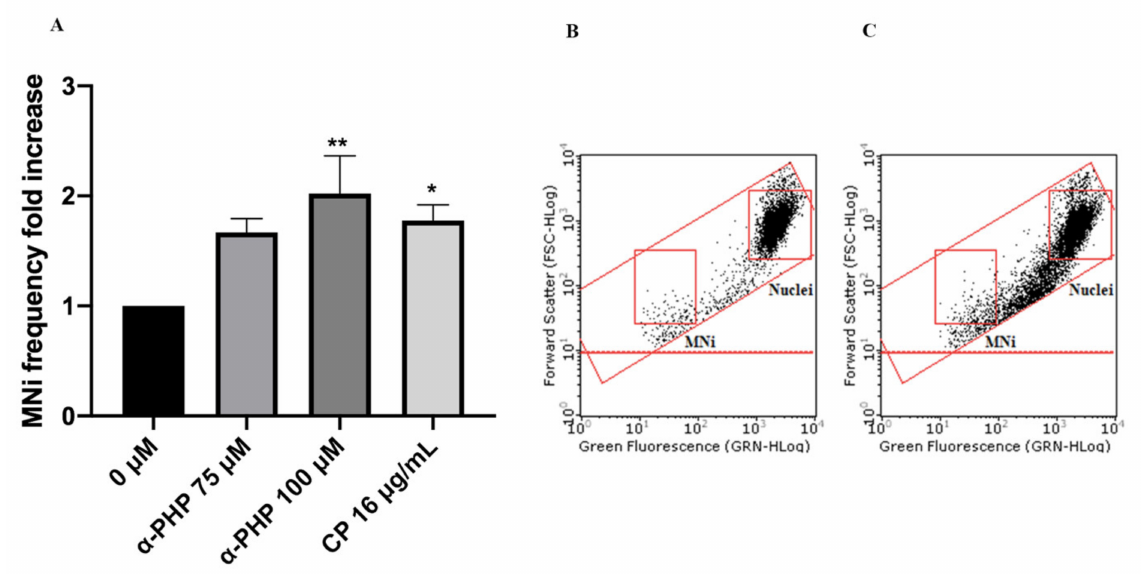
Figure 8. MNi frequency fold increase on TK6 cells after 3 h + S9 mix treatment with α -PHP at the indicated concentrations compared to the negative control [0 µ M] and to the positive control [CP] ( A ), plot of nuclei and Mni in the negative control ( B ) and in 100 µ M α -PHP-treated cultures ( C ). Each bar represents the mean ± SEM of five independent experiments. Data were analyzed using repeated ANOVA followed by Bonferroni post-test. * p < 0.05 vs. 0 µ M; ** p < 0.01 vs. 0 µ M.